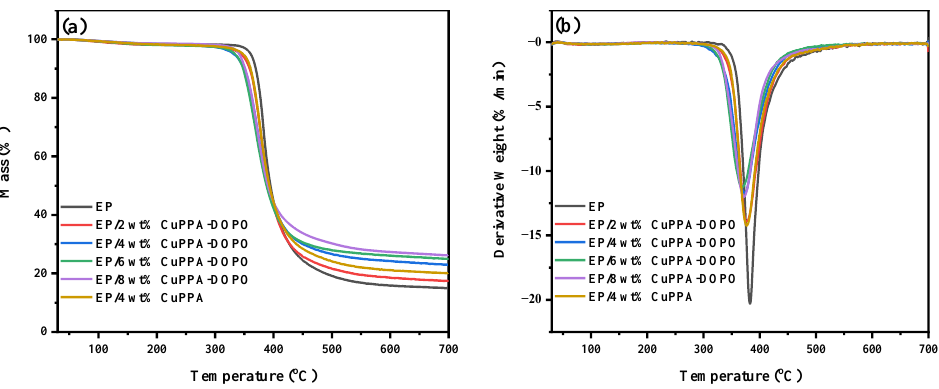
Figure 2. TGA curves of CuPPA, DOPO and CuPPA-DOPO.